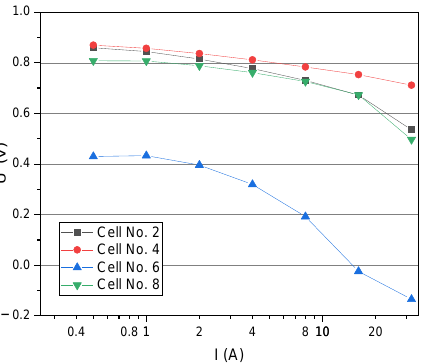
Figure 5. DC voltages U of the studied cells for selected loading currents I.